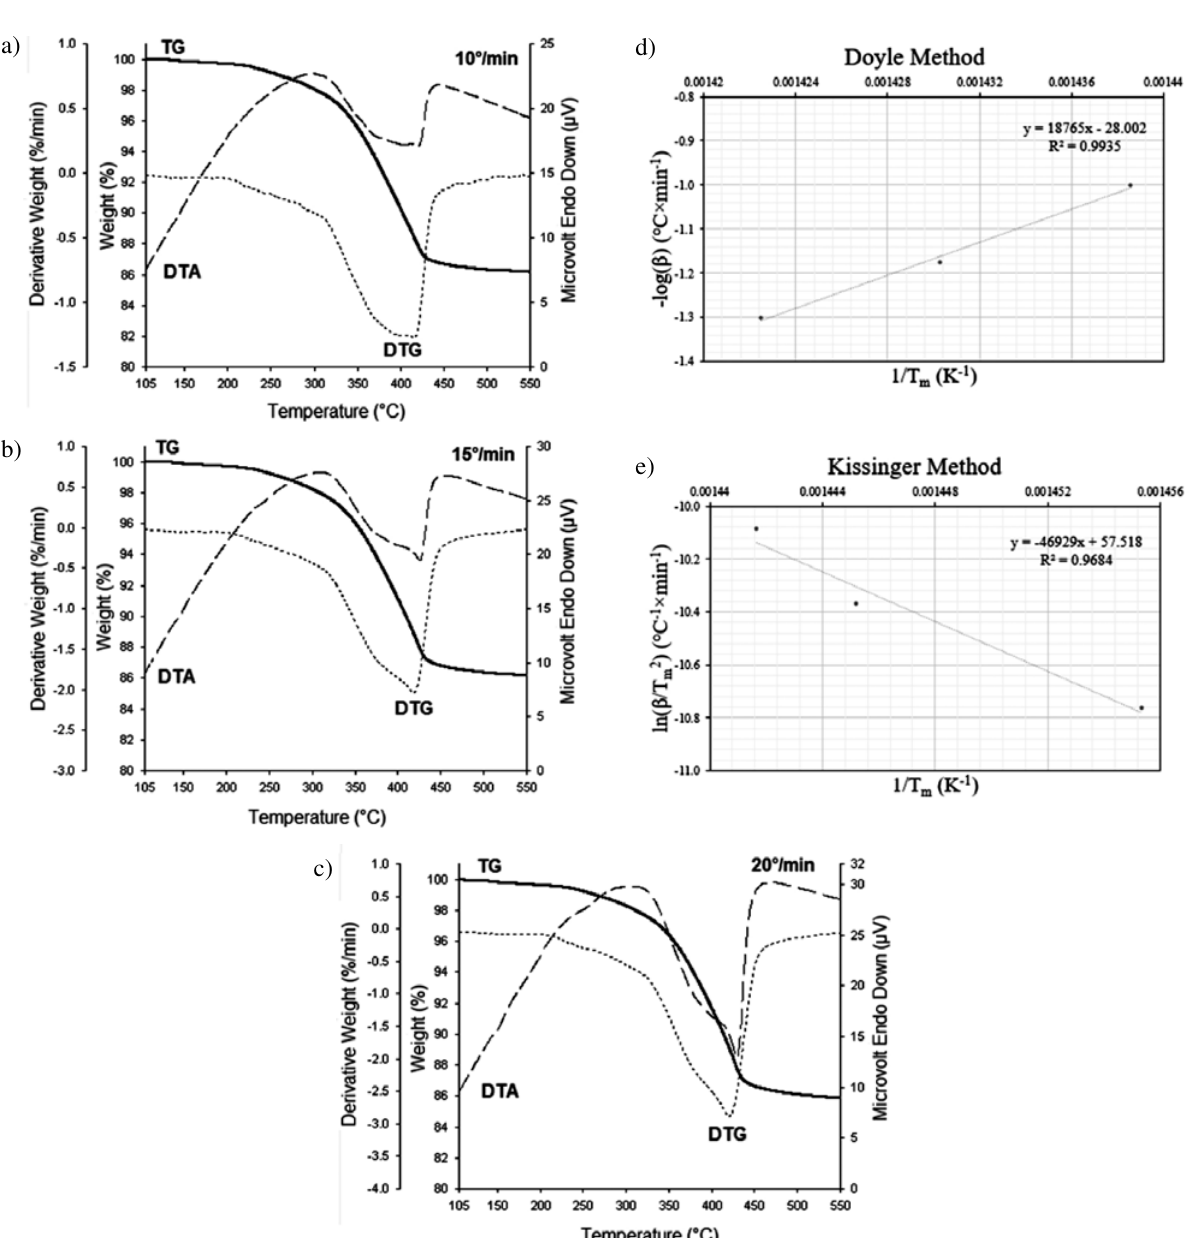
Fig. 5. a. Thermal analysis curves of Zn 3.5H O by Doyle Method, e. Thermal kinetic curves of Zn 2